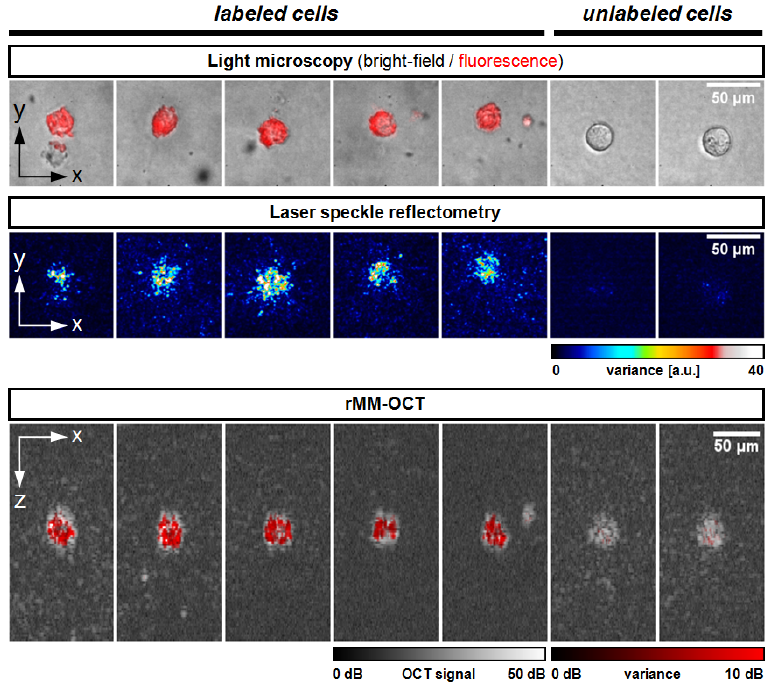
Figure 5. Multimodal light microscopy, laser speckle and rMM-OCT imaging of labeled and unlabeled mesenchymal stem cells (MSCs) embedded in agar scaffolds. The labeled cells are characterized by an intense red fluorescence signal in the microscopy images and a significantly increased variance in both the laser speckle images and the OCT cross-sections, which is caused by magnetically induced motion. In contrast, the unlabeled control cells show no fluorescence and no motion signal (color online). Hypothetically, the pulse length of 80 ms is not long enough to allow the sub-micron particles